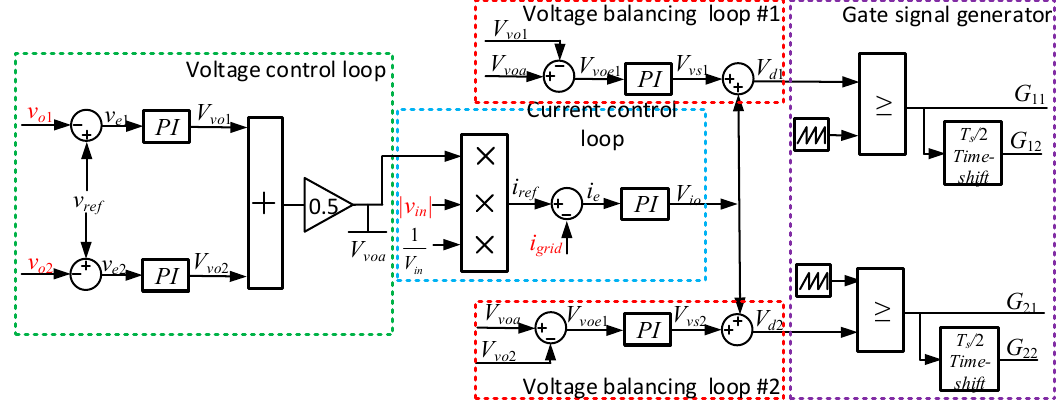
Figure 3. Control scheme for series-connected PFC modules.